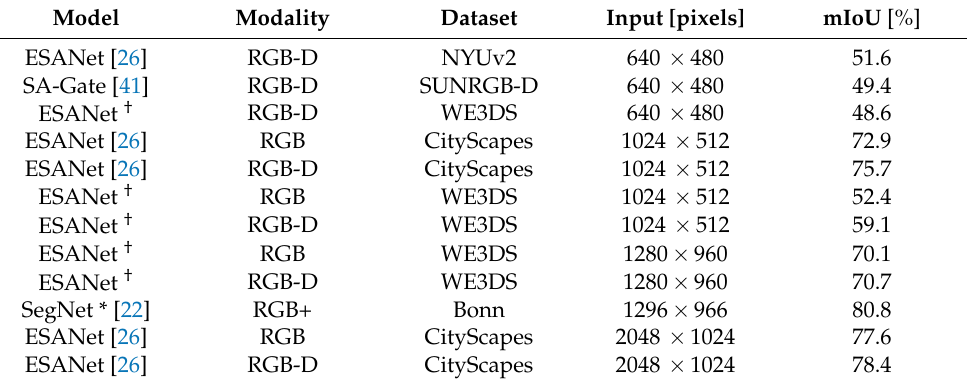
Table 2. Cross-domain comparison of semantic segmentation results. † Models show our results with ESANet on the WE3DS dataset (2568 RGB-D images, 18 classes) and reported performances from the literature on the NYUv2 dataset (1449 RGB-D images, 40 classes), SUNRGB-D dataset (10,335 RGB-D images, 37 classes), CityScapes dataset (5000 RGB-D images, 19 classes), and Bonn dataset (10,036 RGB images, 3 classes). Mean Intersection over Union (mIoU) is given in percent. * Model by [22] is an adapted version of SegNet [52] and was trained on a 14-channel input based on RGB information.